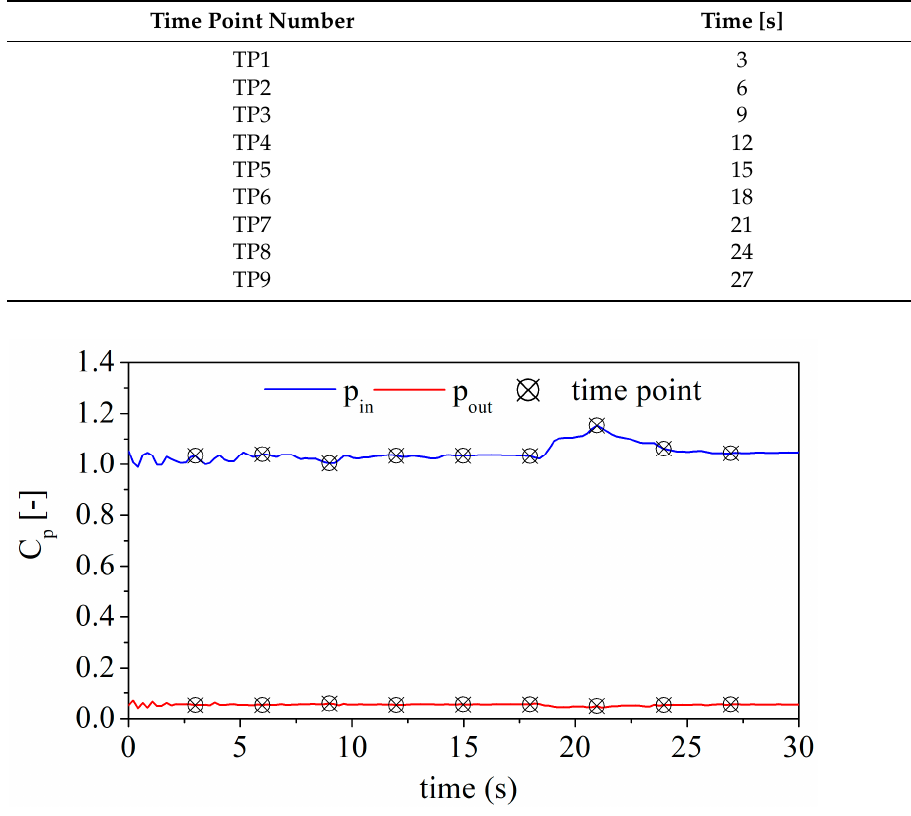
Figure 7. The inlet and outlet boundary conditions. Table 1. Time points.